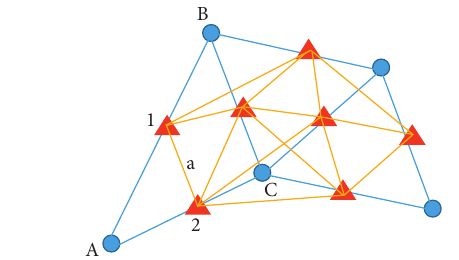
Figure 1: FastGCRNN model.